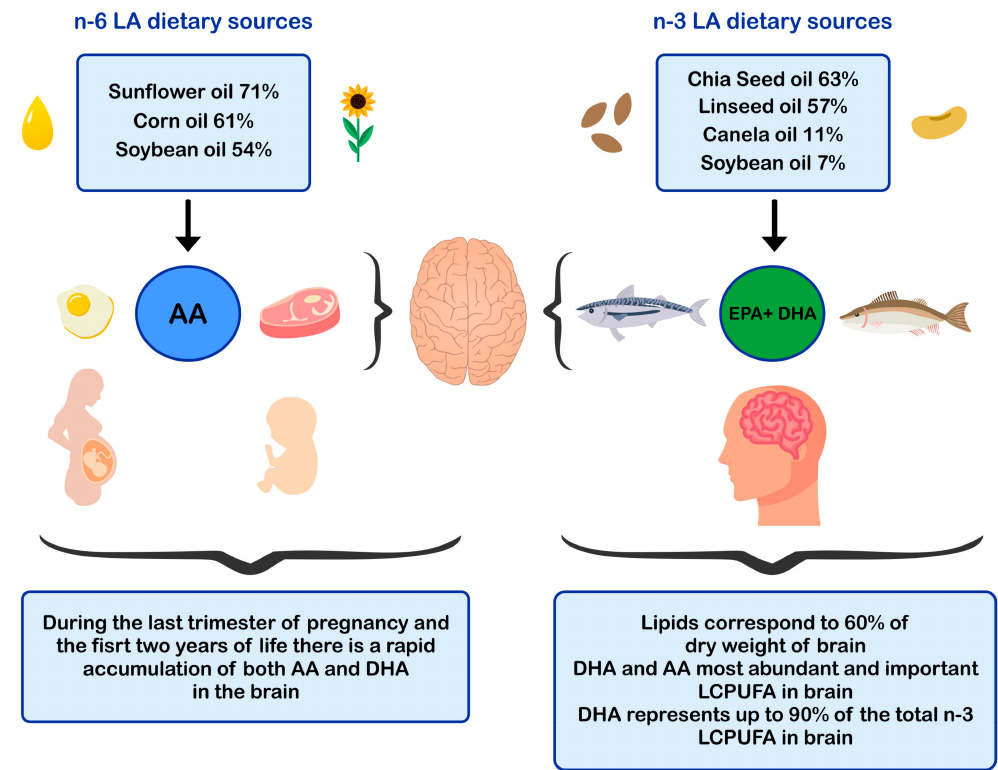
Figure 1. Dietary sources of n-6 and n-3 polyunsaturated fatty acids and impact in brain development. AA: arachidonic acid; EPA: eicosapentaenoic acid; DHA: docosahexaenoic acid; LCPUFA: long-chain polyunsaturated fatty acid; LA: linoleic